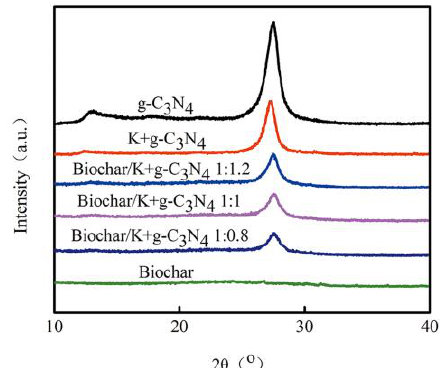
Figure 1. X-ray di ff raction (XRD) patterns of biochar, g-C 3 N 4 , K-doped g-C 3 N 4 and biochar-supported K-doped g-C 3 N 4